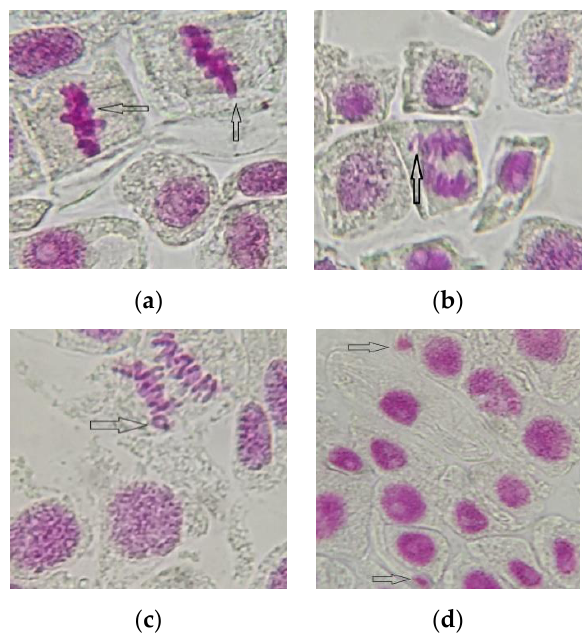
Figure 4. The main chromosomal and nuclear abnormalities identified in meristematic cells of A. cepa exposed to the AESF treatment at 2 and 2.5% (1000× magnification): sticky metaphase ( a ), laggard chromosome in anaphase ( b ); ring chromosomes ( c ); micronucleus ( d ).